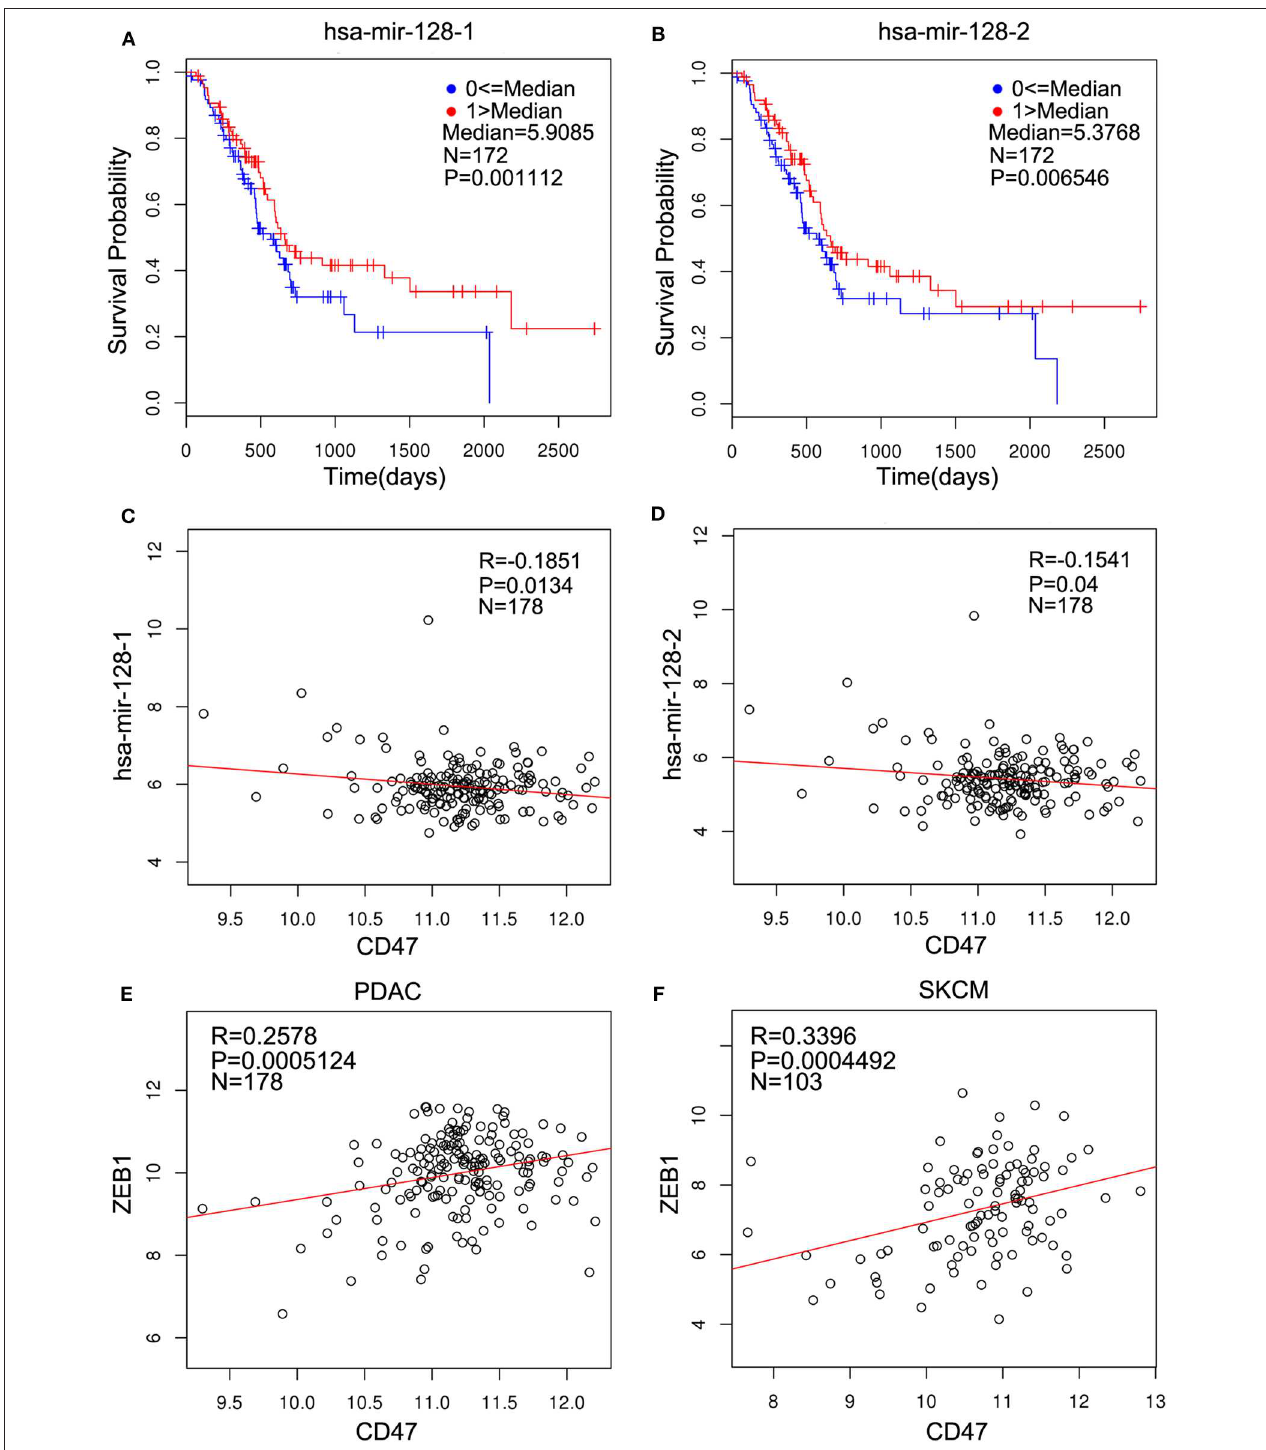
FIGURE 1 | miR-128 is related to overall survival of pancreatic adenocarcinoma (PDAC) and inversely correlated with cluster of differentiation 47 (CD47), which is positively related to zinc finger E-box-binding homeobox 1 (ZEB1) in PDAC. The clinical relevance was analyzed using the LinkedOmics database. (A,B) High expression of hsa–mir-128-1 ( A , N = 172, p < 0.01) and hsa–mir-128-2 ( B , N = 172, p < 0.01) indicates better progression-free survival in patients with PDAC. (C,D) Hsa–mir-128-1 ( C , N = 178, R = − 0.1851, p < 0.05) and hsa–mir-128-2 ( D , N = 178, R = − 0.1541, p < 0.05) are inversely related to CD47 in PDAC. (E,F) CD47 is positively related to ZEB1 in PDAC (E , N = 178, R = 0.2578, p < 0.001) and skin cutaneous melanoma (SKCM) (F , N = 103, R = 0.3396, p < 0.001).